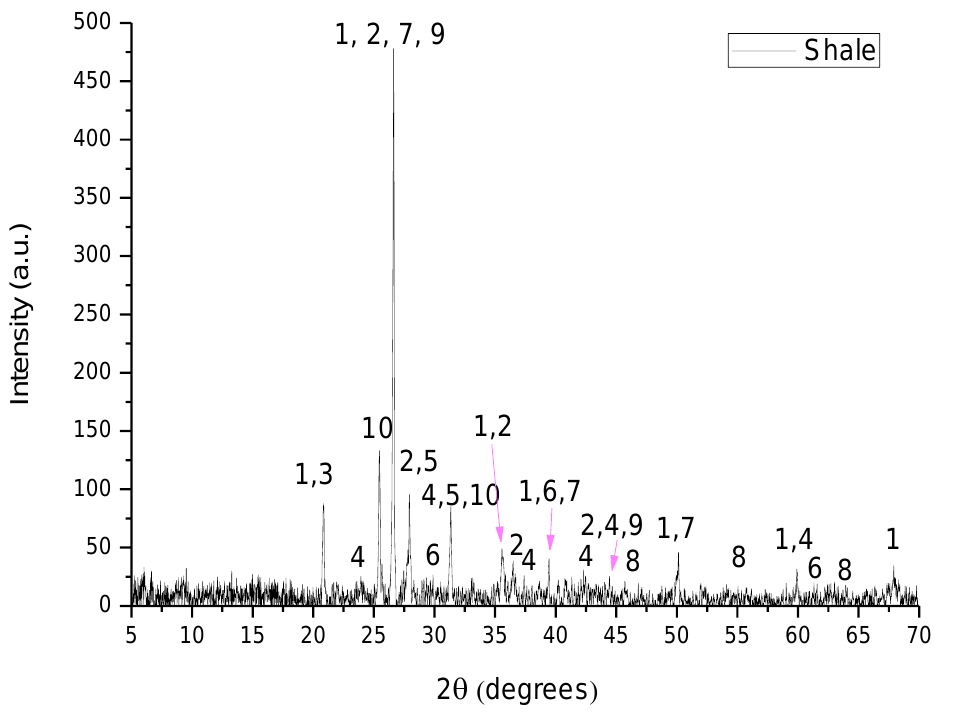
Figure 3. XRD pattern of shale where 1: quartz, 2: illite, 3: kaolinite, 4: dolomite, 5: albite, 6: calcite, 7: microcline, 8: hematite, 9: muscovite and 10: clinochlore.